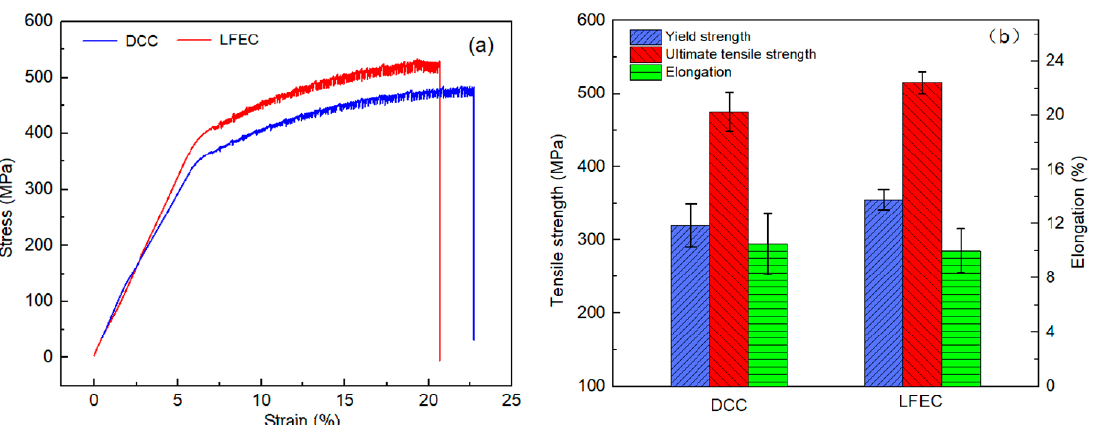
Figure 12. Mechanical properties of the 5A90 DCC and LFEC as-aged alloys. ( a ) engineering stress-strain curves; ( b ) tensile properties.